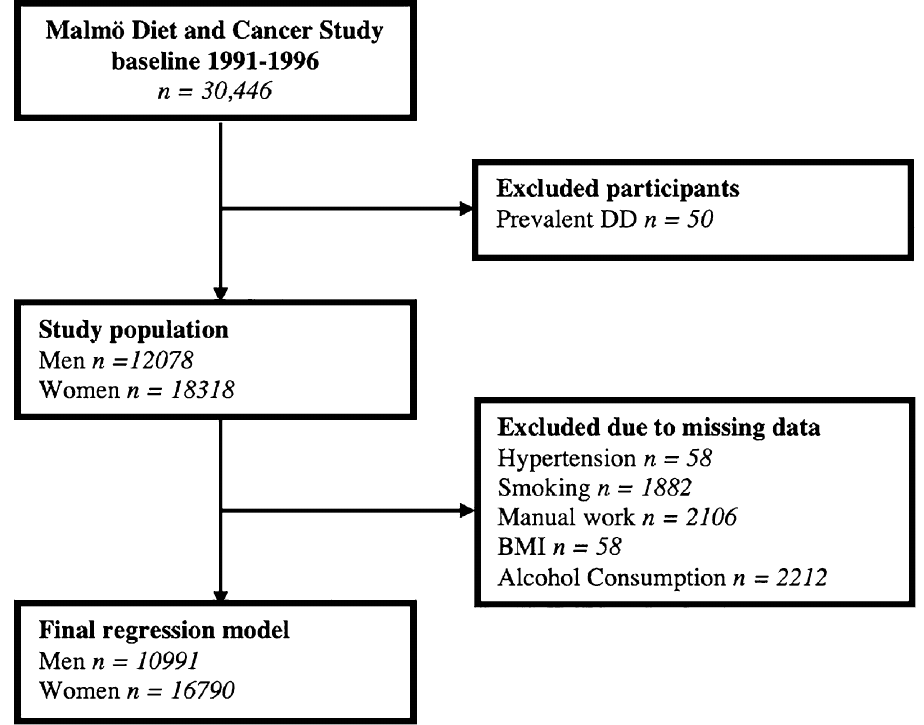
Figure 1. Derivation of the study cohort from the Malmö Diet and Cancer Study (MDCS). BMI body mass index, DD Dupuytren’s disease.